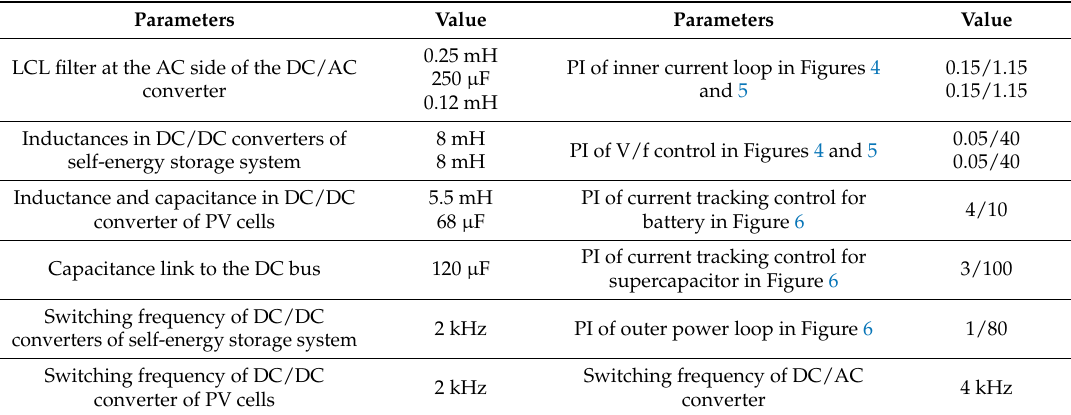
Table 3. Simulation parameters of energy